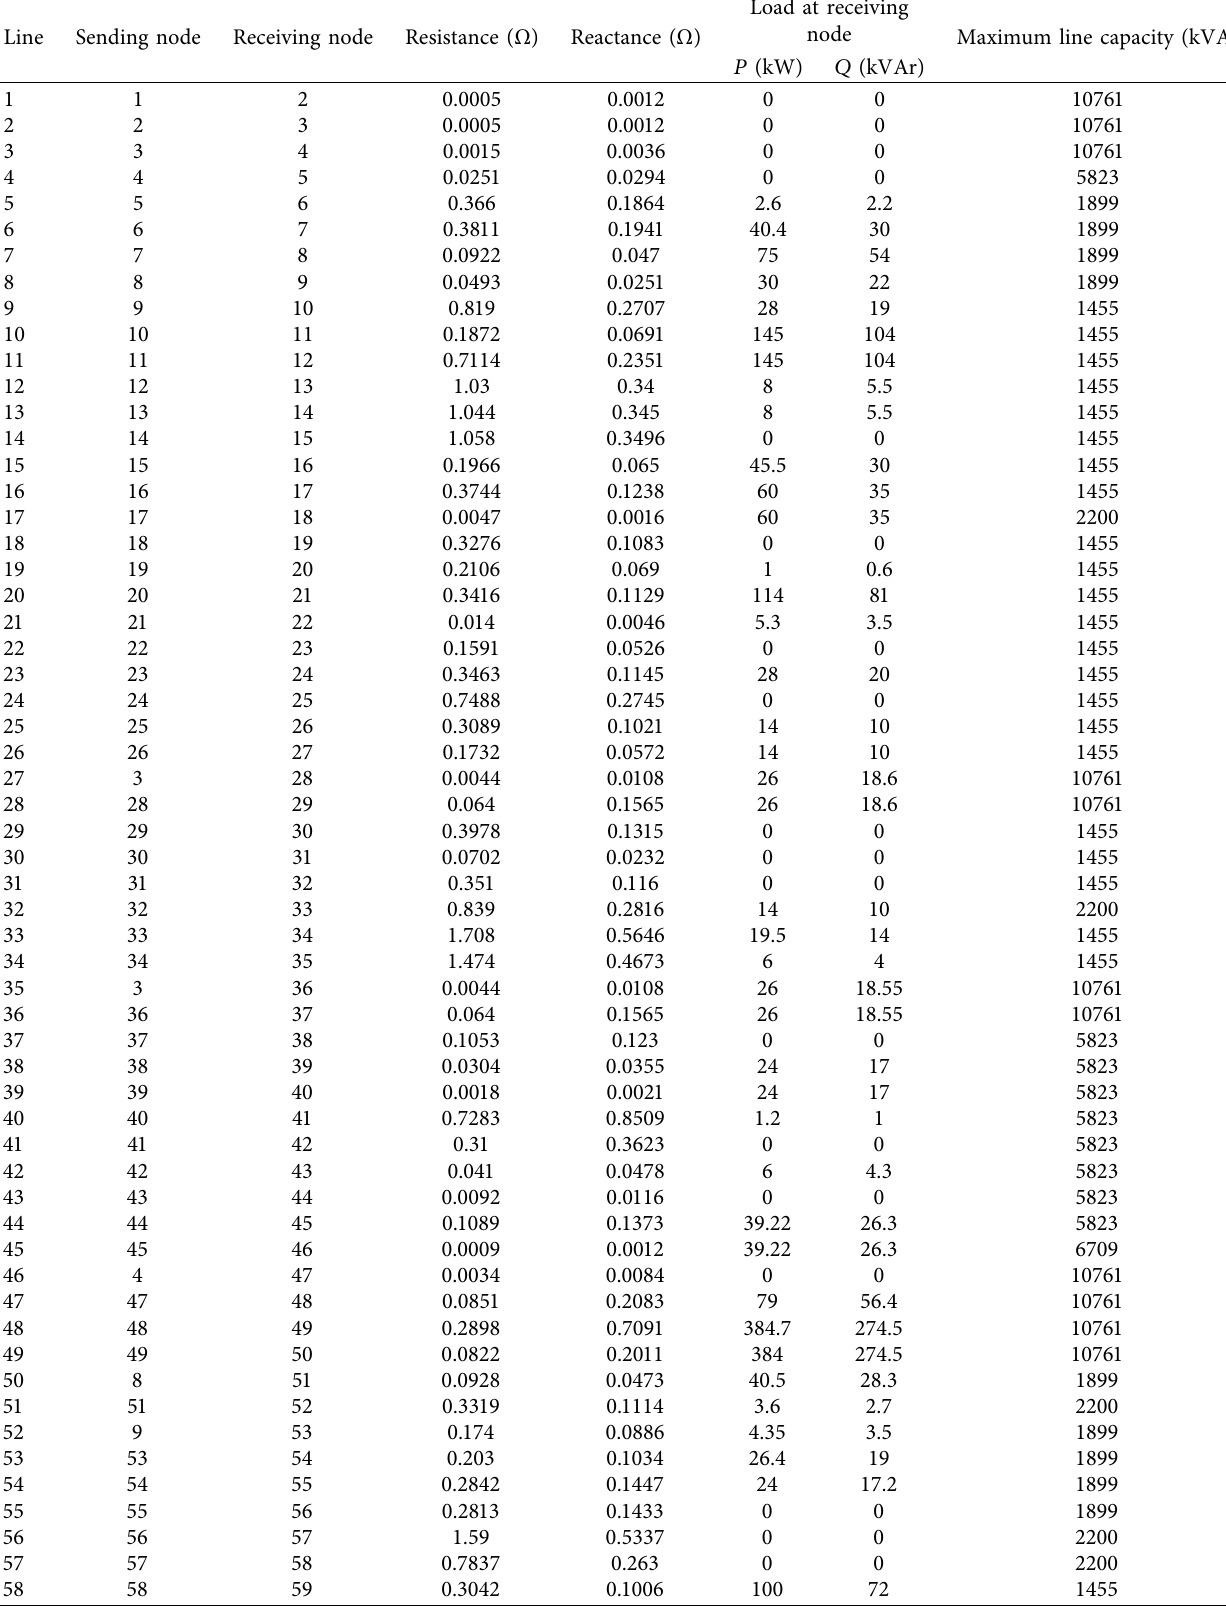
Table 4: Data of the second system with 69